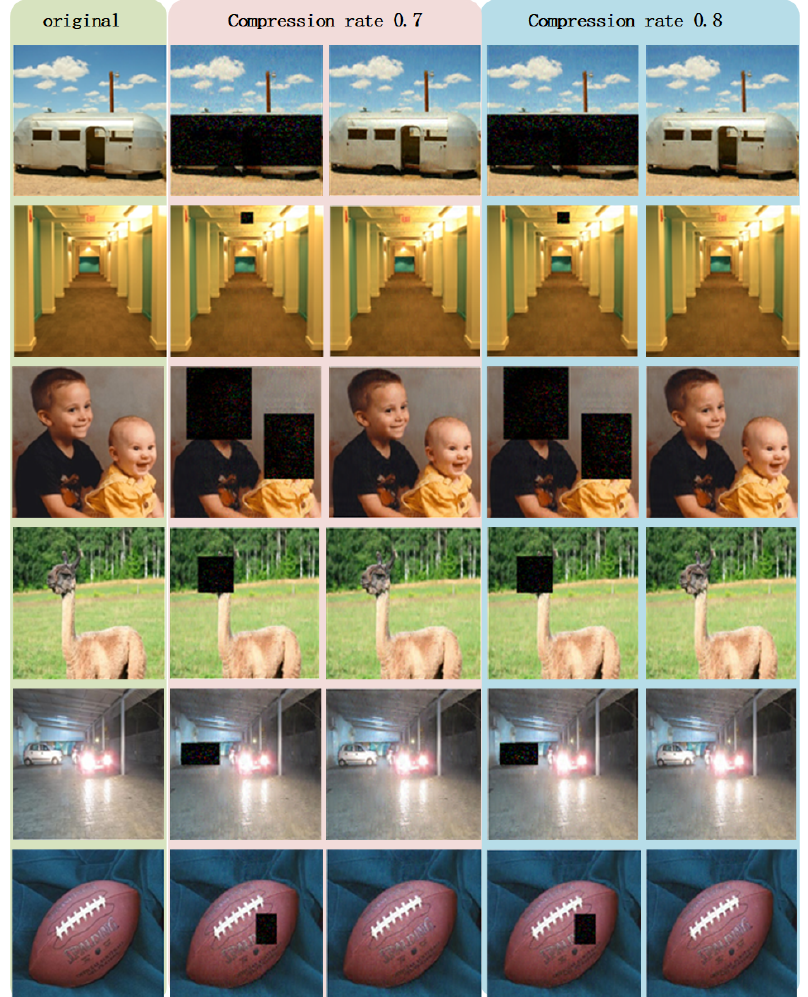
Figure 3. The first column shows the original images named trailer, hallway, kids, llama, car, and football, respectively. The second column shows the reconstructed images obtained by restricted- authorized receivers under compression rate 0.7. The third column shows the reconstructed images obtained by full-authorized receivers under compression rate 0.7. The fourth column shows the reconstructed images obtained by restricted-authorized receivers under compression rate 0.8. The fifth column shows the reconstructed images obtained by full-authorized receivers under compression rate